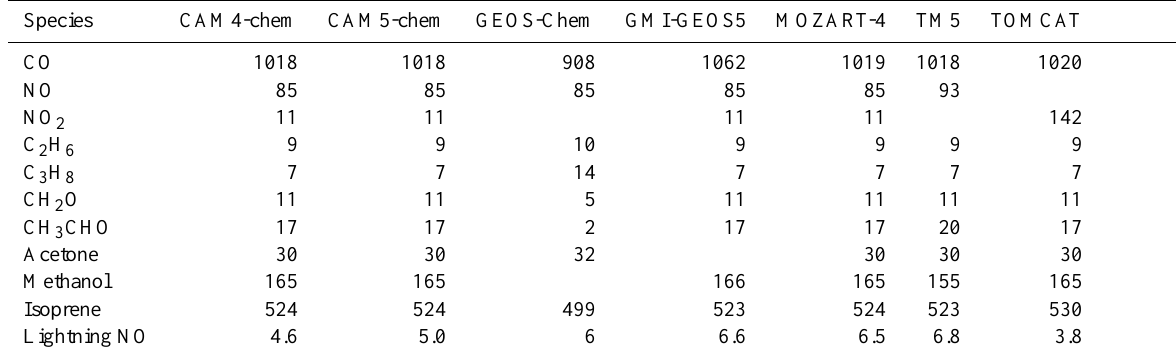
Table 2. Global emissions actually used in each model (Tgyr − 1 , except lighting: TgNyr − 1 ).